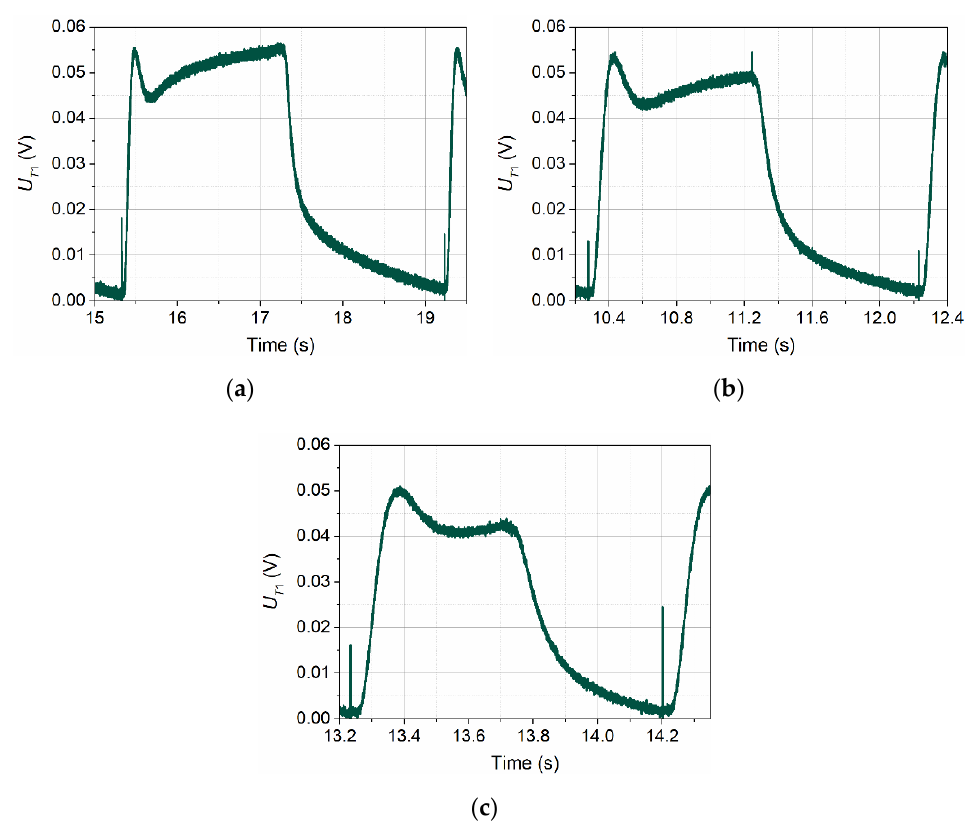
Figure 3. Shapes of voltage signals recorded by detector T1 in conditions of no flow for three different frequencies of the transmitter wave: f = 0.25 Hz ( a ), f = 0.50 Hz ( b ), and f = 1.00 Hz ( c ).